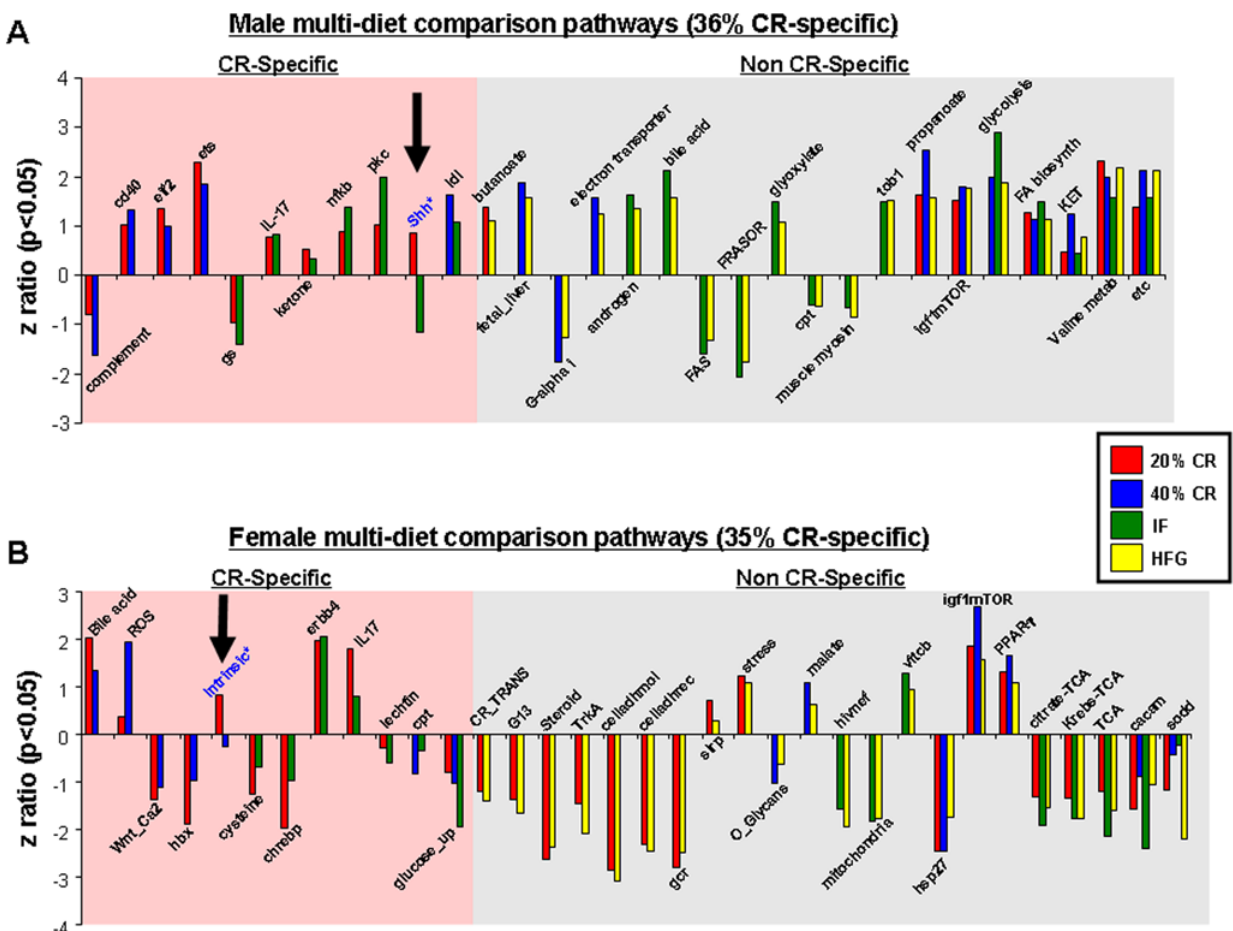
Figure 13. Caloric specificity of male and female multi-diet regulated pathways. Significantly altered functional pathways that were common between diet paradigms were drawn to visualize caloric specificity. (A) Commonly altered functional pathways in the testes of male rats on the various diets showed 36% caloric restriction (CR) specificity (commonly regulated between the 20% CR, 40%, CR, and/or IF diets only) and 64% non-CR specificity. (B) Similarly, the commonly altered functional pathways in the ovaries showed 35% CR-specificity and 65% non-CR specificity. Names of the significantly altered pathways can be found in Table S2.